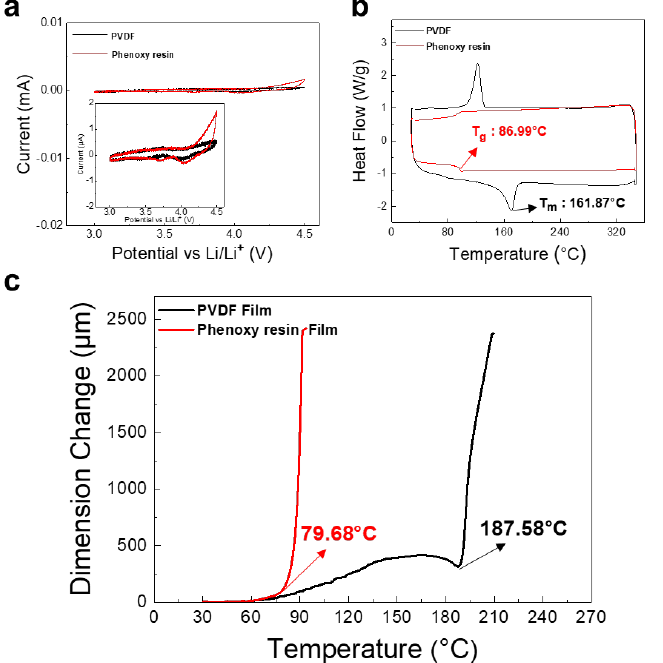
Figure 2. ( a ) CV curves for PVDF and phenoxy resin film measured at a scan speed of 2 mV sec − 1 in the range of 3 – 4.5 V ( b ) DSC curves for PVDF and phenoxy resin powder measured at a heating rate 10 °C/min in a temperature range of 30 – 350 °C ( c ) Thermal mechanical analysis (TMA) of PVDF film and phenoxy resin film in the temperature range of 30 – 240 °C.